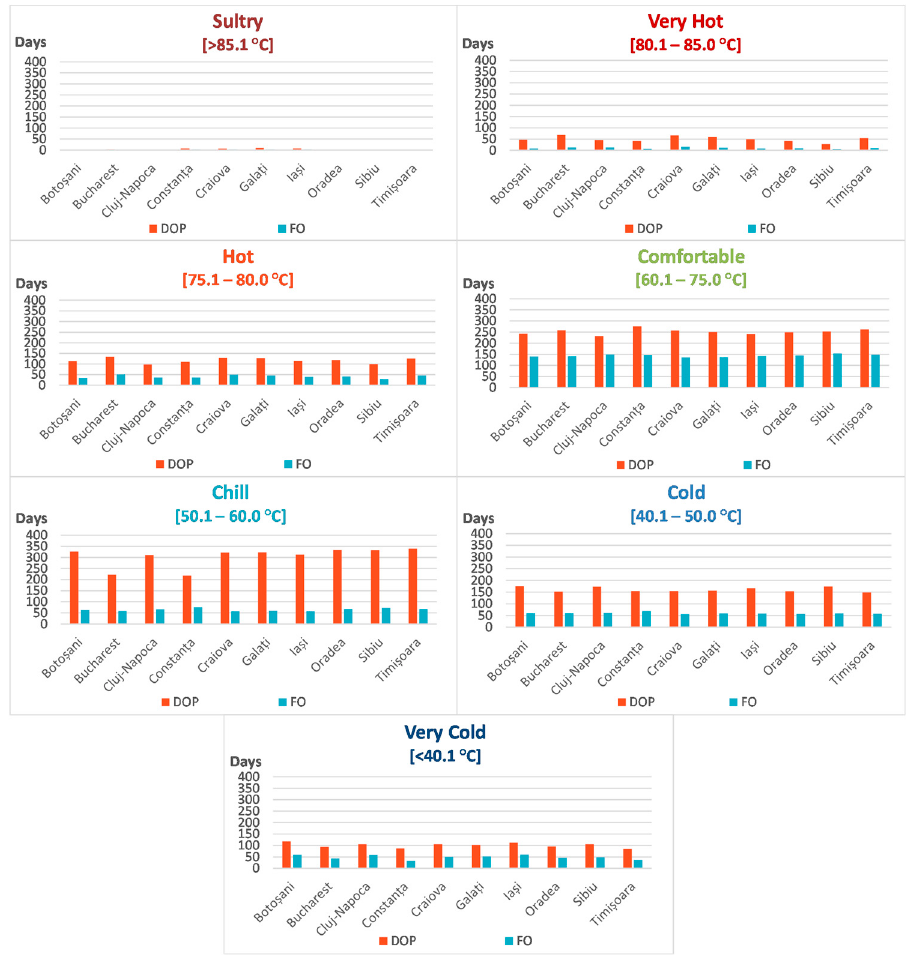
Figure 14. DOP and FO for the THI index by thermal sensations classes and weather stations (number of days).